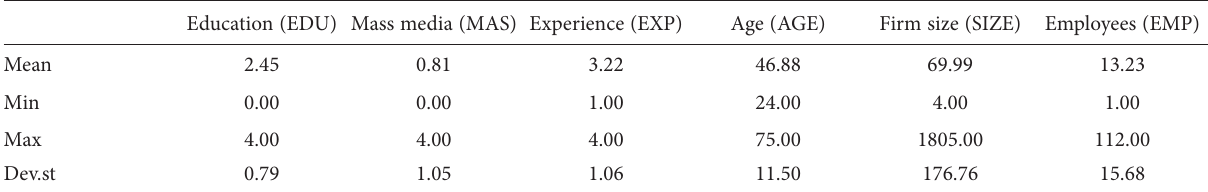
Table 2. Statistics of the socio-demographics independent variables.